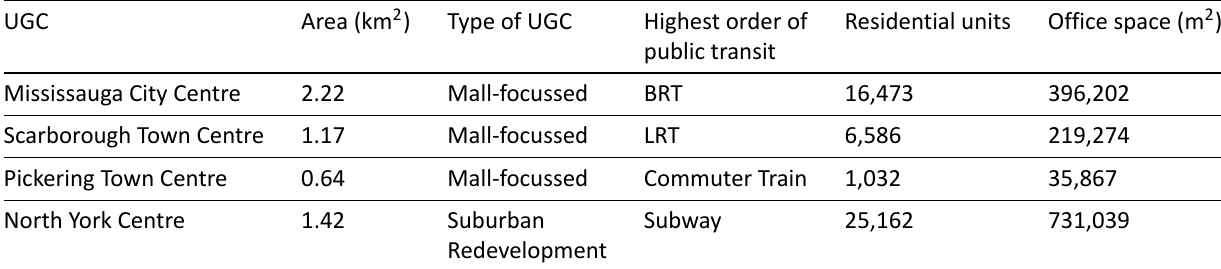
Table 1. General characteristics of the four main Toronto suburban UGCs.